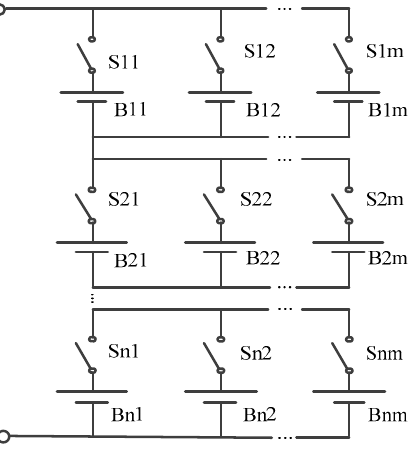
Figure 2. Battery pack parallel-series fault-tolerant Figure 2. Ba tt ery pack parallel-series fault-tolerant structure.